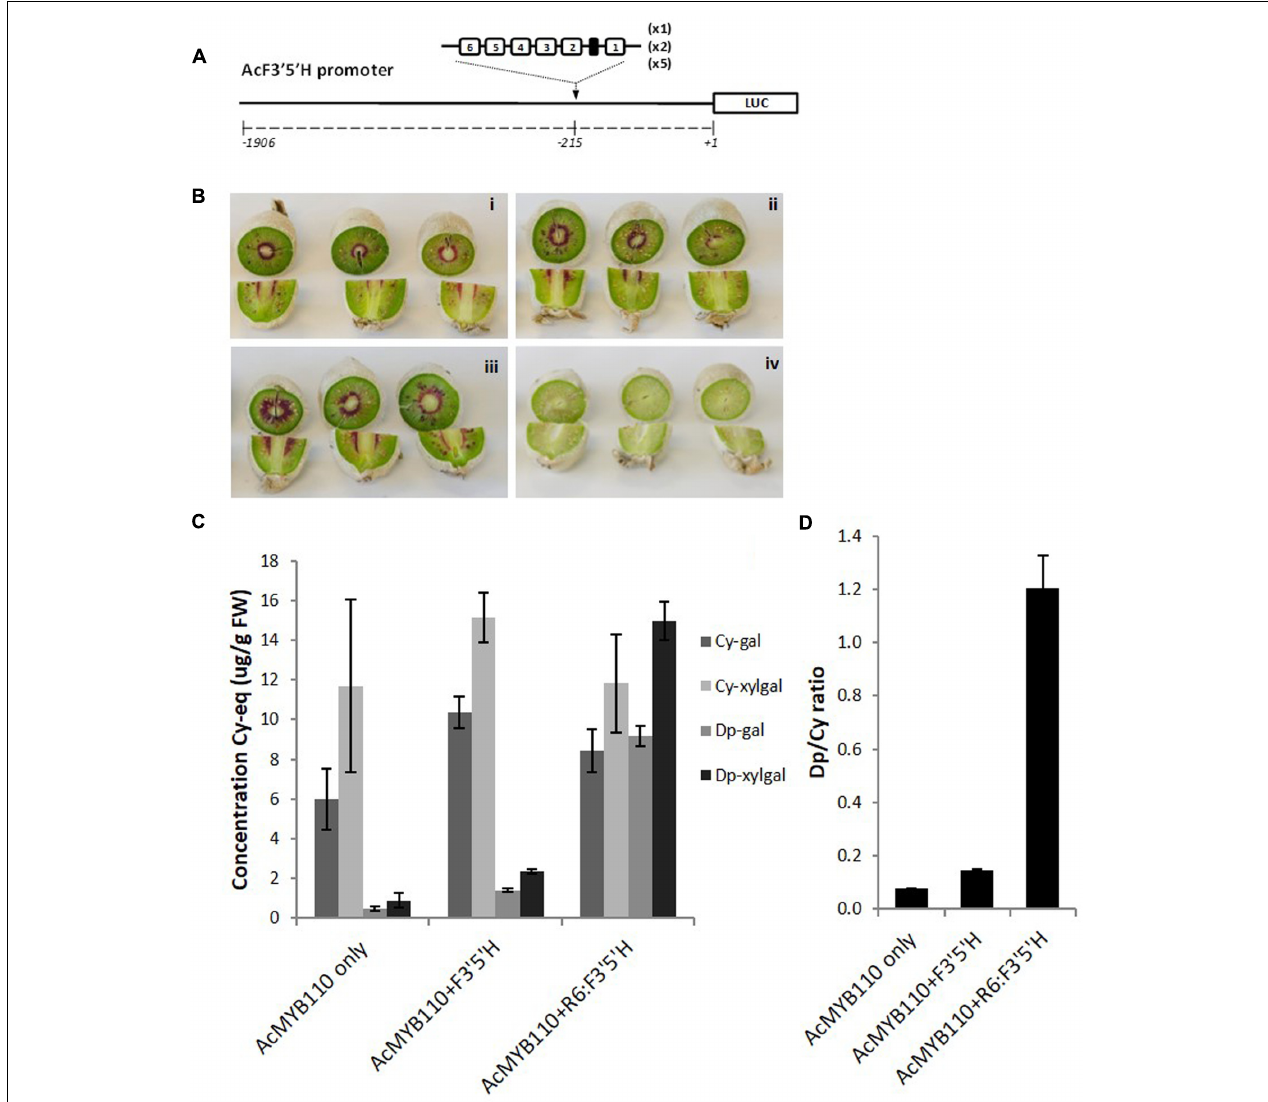
FIGURE 7 | Insertion of the R6 motif into the AcF3 (cid:48) 5 (cid:48) H promoter induces accumulation of delphinidin derivatives. (A) Schematic of the engineered F3 (cid:48) 5 (cid:48) H promoter fused to the LUC reporter gene in pGreen0800LUC. (B) Actinidia eriantha kiwifruit were infiltrated by Agrobacterium suspension containing AcMYB110 (i), AcMYB110 and F3 (cid:48) 5 (cid:48) H pro : F3 (cid:48) 5 (cid:48) H (ii), AcMYB110 and F3 (cid:48) 5 (cid:48) H-R6 pro : F3 (cid:48) 5 (cid:48) H (iii) constructs and corresponding empty vectors (iv). Photos were taken 4 days post-infiltration. (C) Measurement of cyanidin and delphinidin derivatives in kiwifruits expressing corresponding constructs, expressed as concentration of cyanidin-gal equivalent and (D) presented as a ratio of delphinidin to